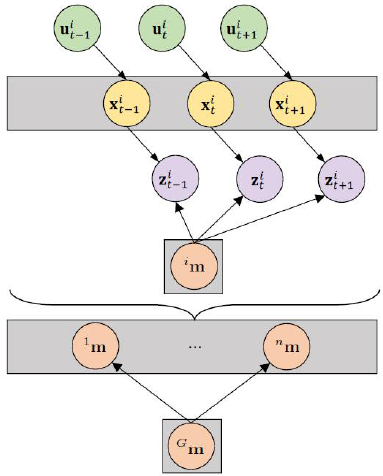
Figure 4. Graphical model of the map fusion problem (indirect solution) for n robots.